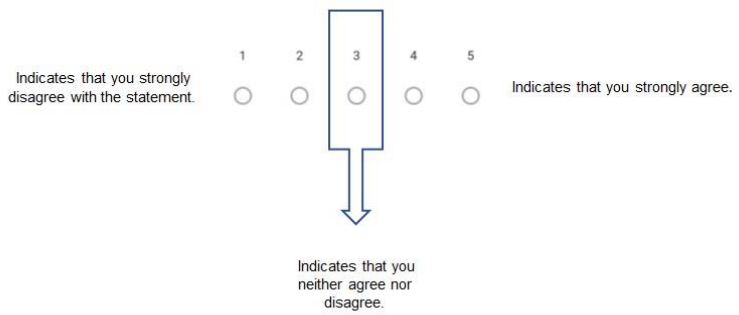
Figure 1. Visual scale Delphi questionnaire.